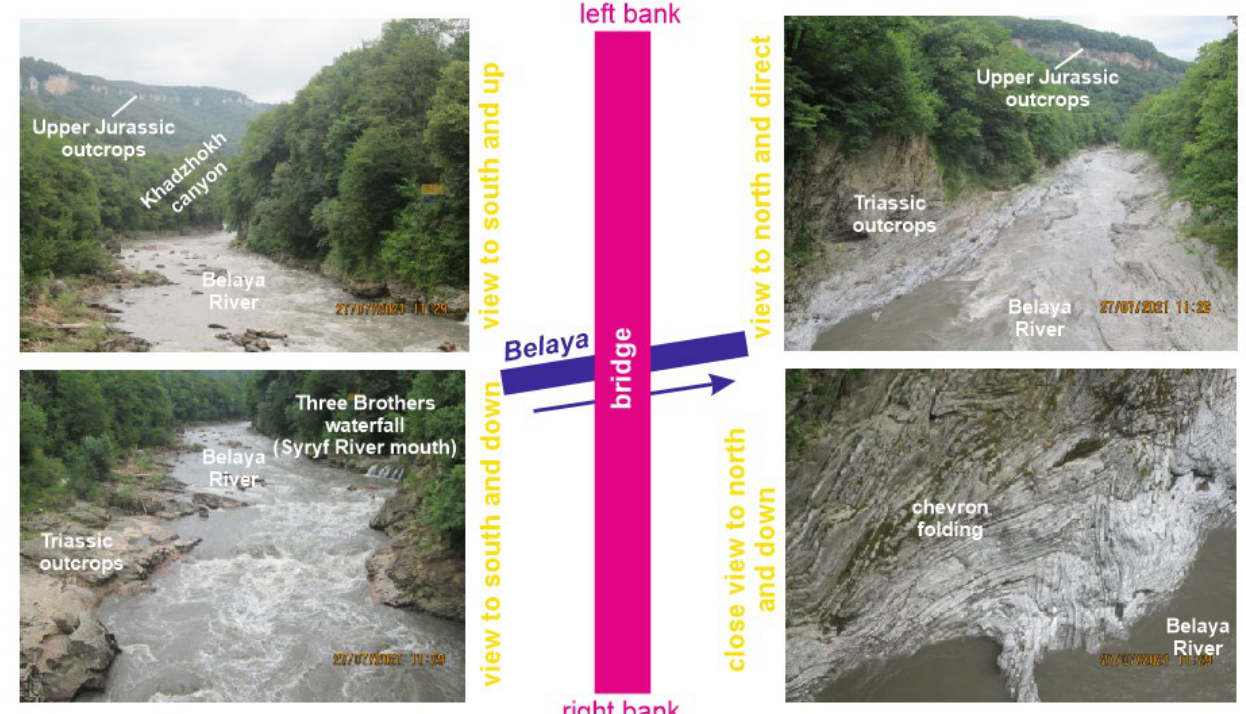
Figure 3. The entrance bridge to the Rufabgo tourist attraction.